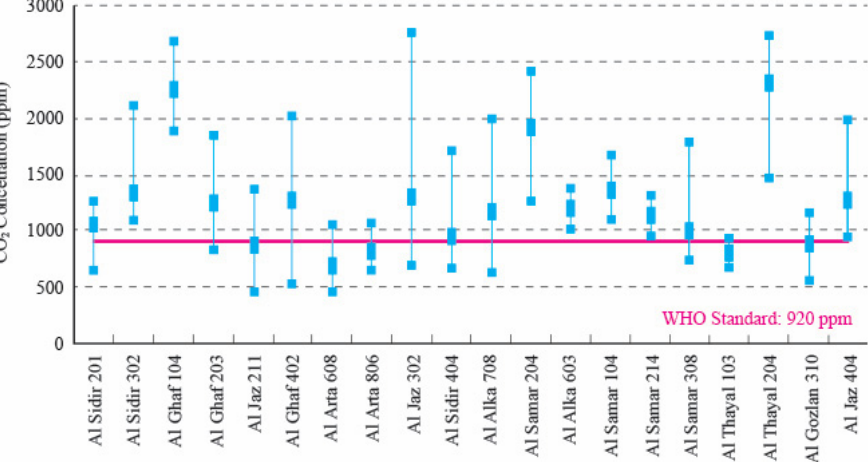
Figure 3. CO 2 concentrations in 20 housing units at The Greens, Dubai.